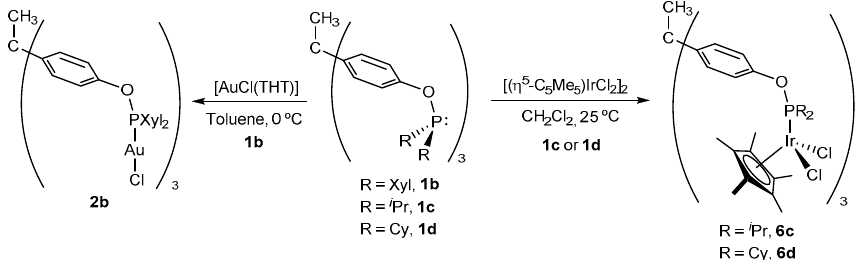
Figure 5. Projection of the crystal structure of 6a along [0 0 1] highlighting intermolecular π - π (red dotted lines) and C—H/ π (blue dotted lines) interactions between triiridium compounds. Each molecule of 6a has been highlighted in different colors for clarity, while metal centers are represented as balls.